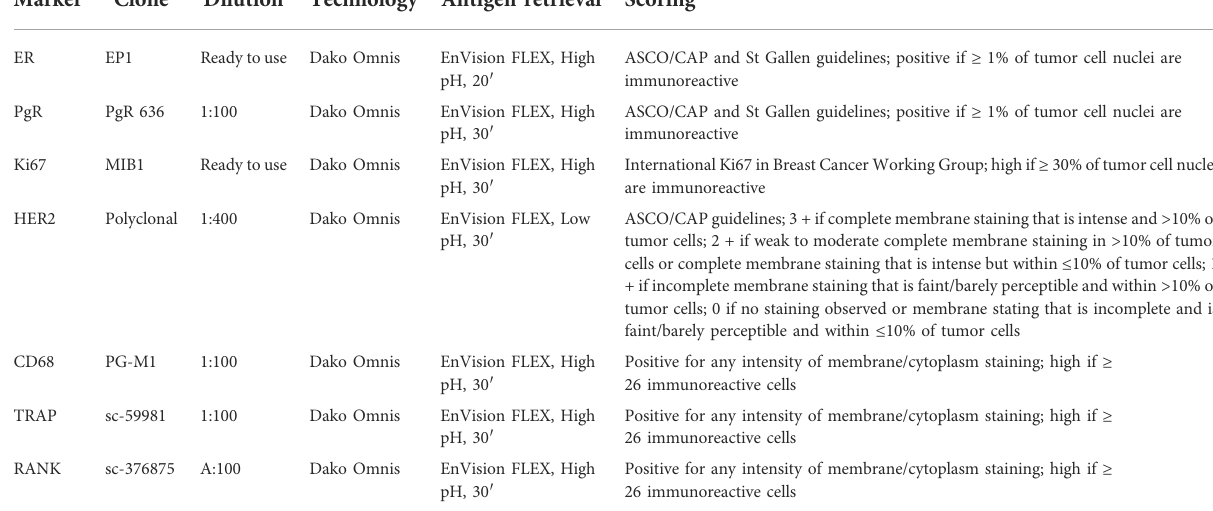
TABLE 1 List of antibodies, clones, dilutions, antigen retrieval methods, and scoring systems adopted for immunohistochemical analyses.